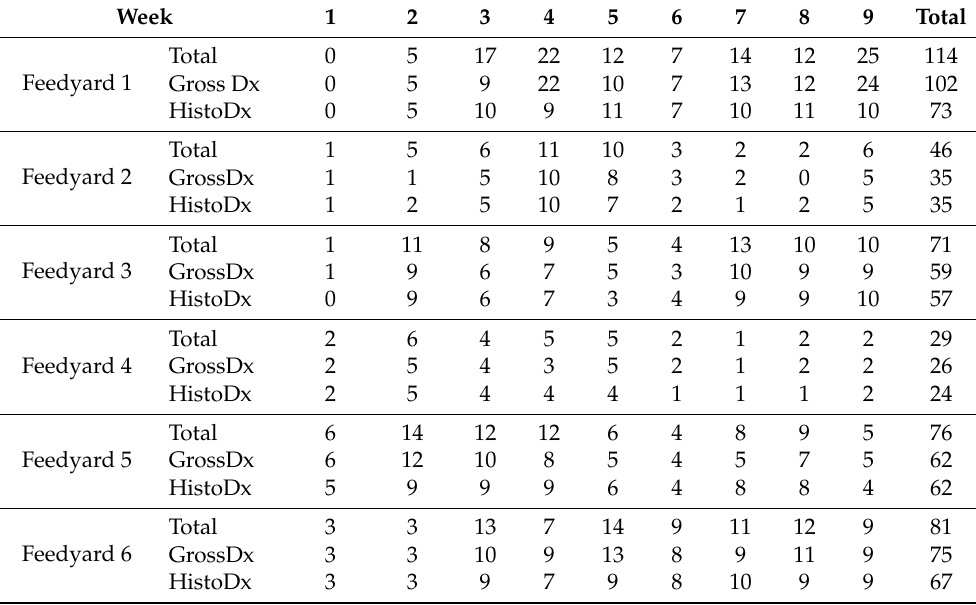
Table 2. Descriptive table of gross necropsies performed at each feedyard ( n = 417). Mortalities with gross respiratory lesions ( n = 359) and allocation of histopathological lung samples ( n =